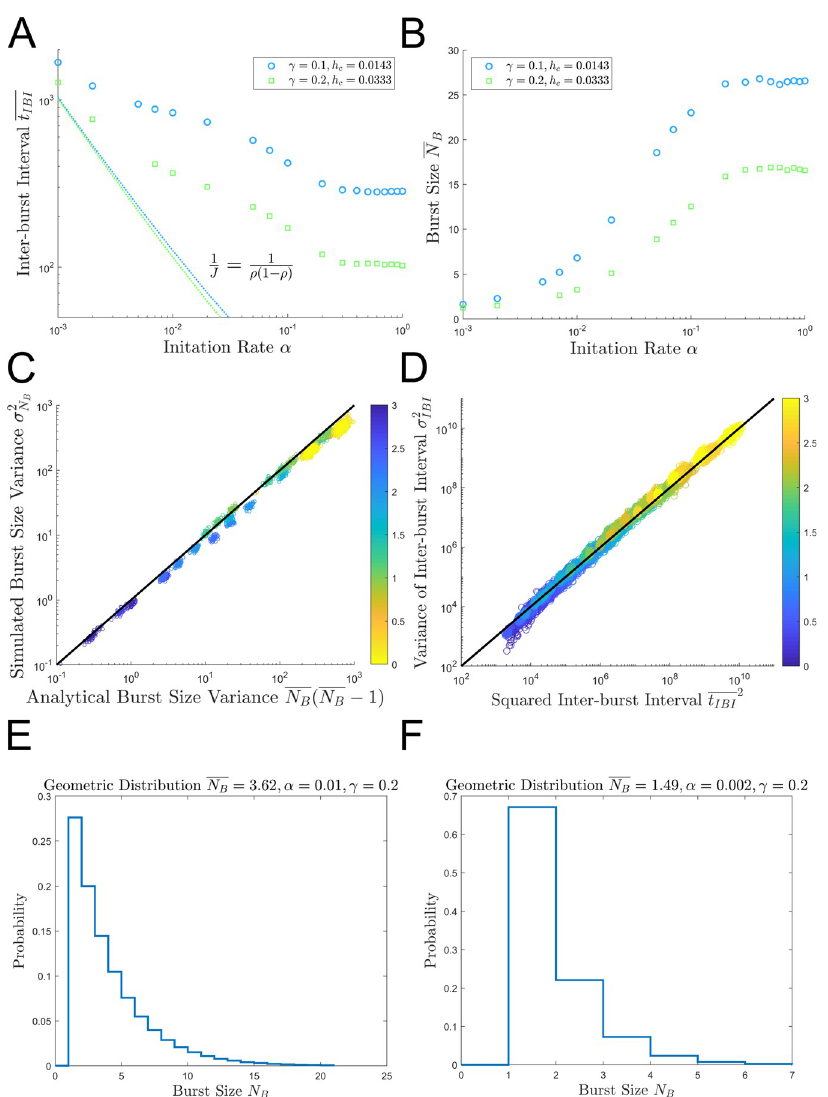
Fig 8. Bursting in the low initiation rate regime. (A) shows the average inter-burst interval t the headway distribution prediction for the average waiting time t size N plotted as a function of α . Panels (A) and (B) were generated with Fig 5D–5F with α 2 [0.001, 1] with h B h o 2 {0.0143, 0.033} to achieve γ 2 {0.1, 0.2}. (C) shows that the variance of burst size s 2 variance of a geometric distribution given by Eq 46 and is colored by − log 10 α . (D) compares the mean inter-burst interval and the variance of the inter-burst intervals to establish that the waiting time distribution is exponentially distributed using the data from Fig 5A–5C and is colored by − log 10 γ . (E) and (F) show representative burst size probability mass functions generated from geometric distributions with means given by N with the parameter sets ( α = 0.01, γ = 0.2) and ( α = 0.002, γ =